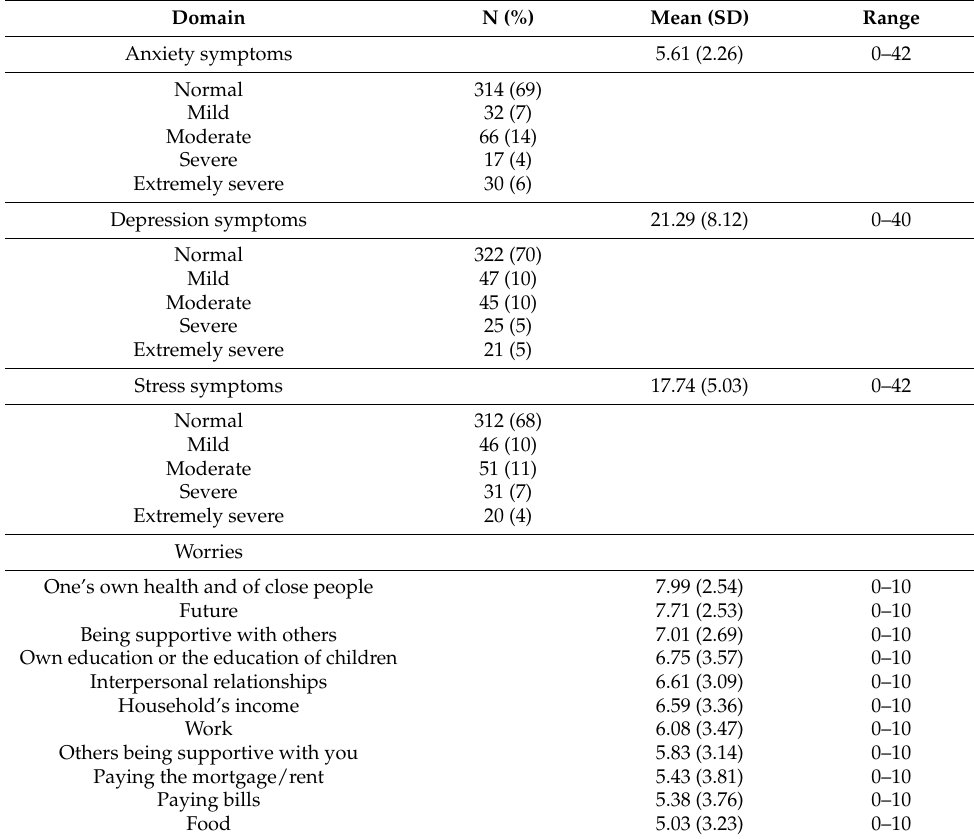
Table 2. Descriptor statistics for mental health-related variables (N =